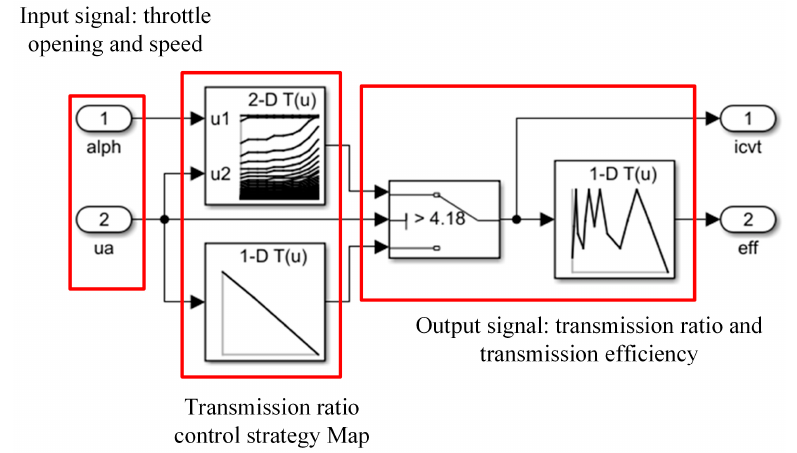
Figure 9. Transmission ratio control strategy model of HMCVT.